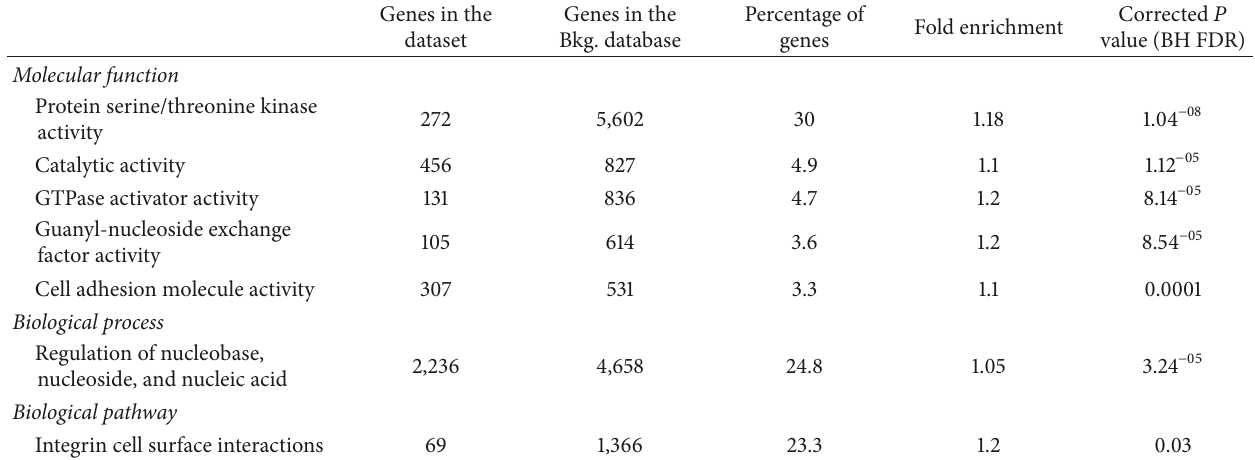
Table 6: Functional enrichment analysis of HIV+ EV proteins.